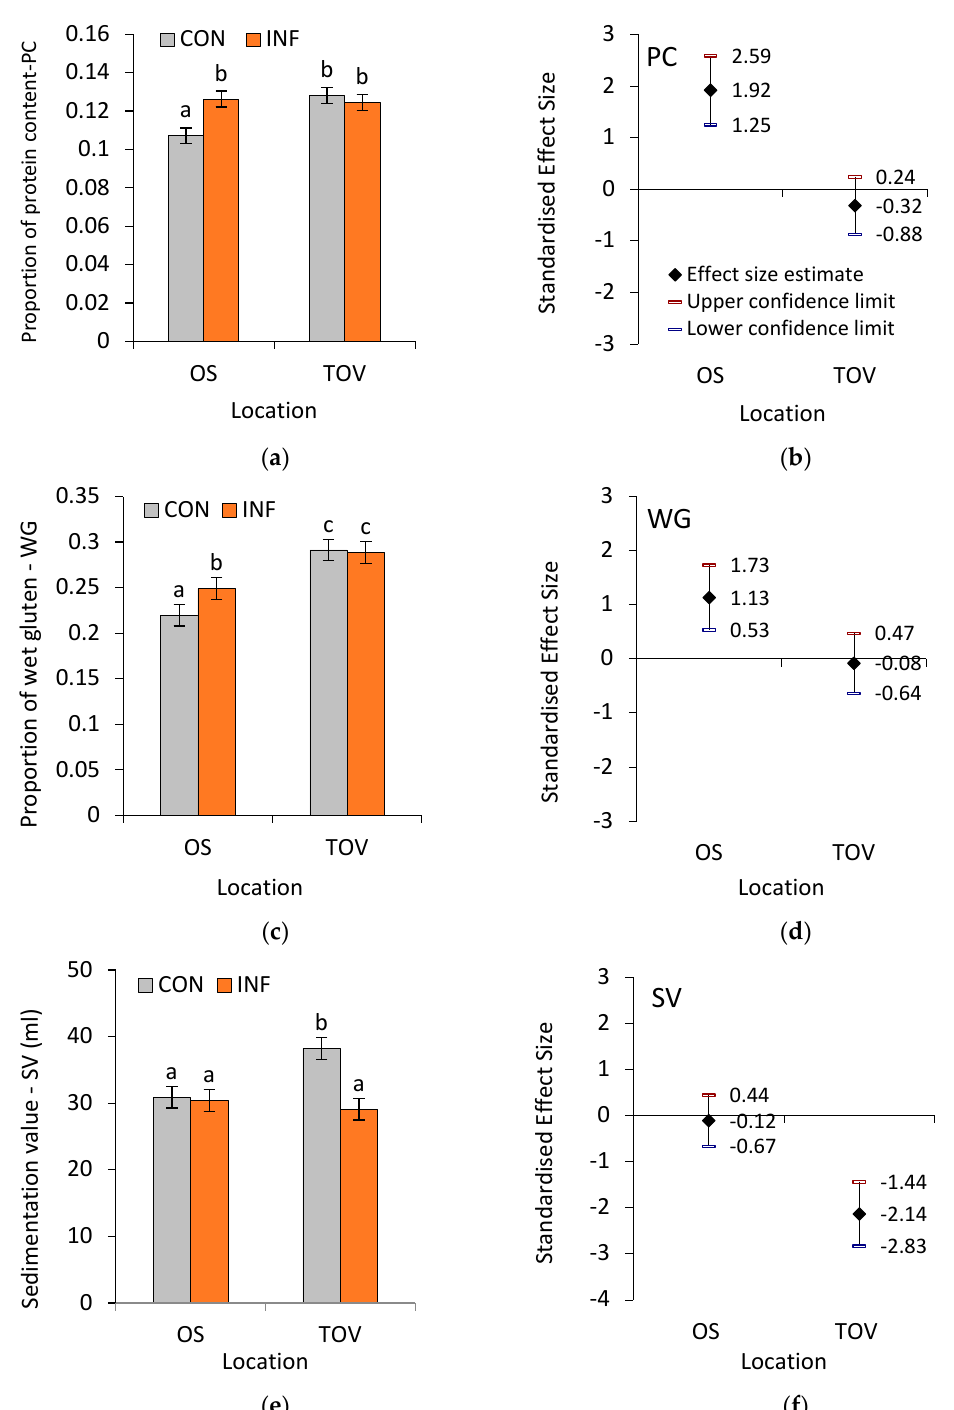
Figure 1. Average values and 95% confidence interval of ( a ) protein content (PC) proportion in wheat grains, ( c ) proportion of wet gluten content (WG), ( e ) sedimentation value (SV, mL) in control (uninfected, CON) (n = 25) and infected (INF) (n = 25) flour samples of winter wheat cultivars grown at Osijek (OS) and Tovarnik (TOV) locations. An estimate of standardized effect size with a 95% confidence interval of Fusarium infection on PC ( b ), WG ( d ), and SV ( f ) of winter wheat cultivars grown at OS and TOV. For all variables with the same letter, the difference in means is not statistically significant (at p < 0.05, Tukey HSD).